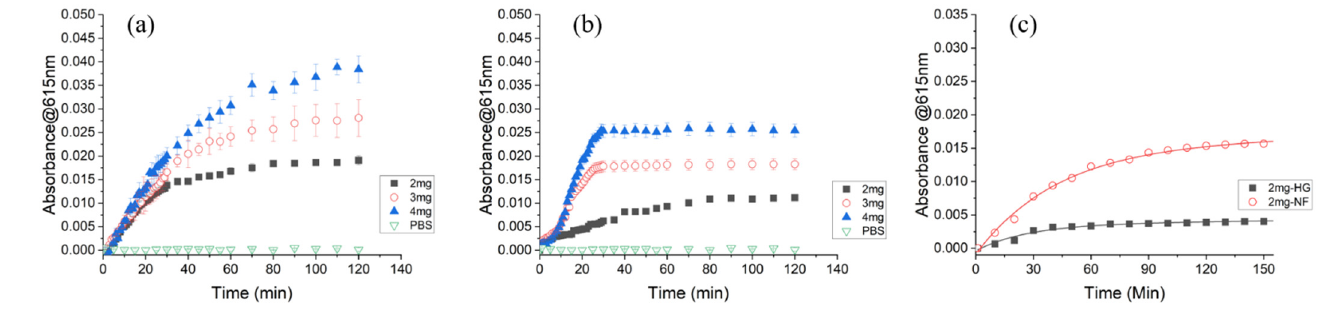
Figure 8. Enzyme reaction kinetics for varied amounts of ( a ) CS/PEO NFs, ( b ) CS/PEO HGs and ( c ) comparison of reaction kinetics for 2 mg samples.